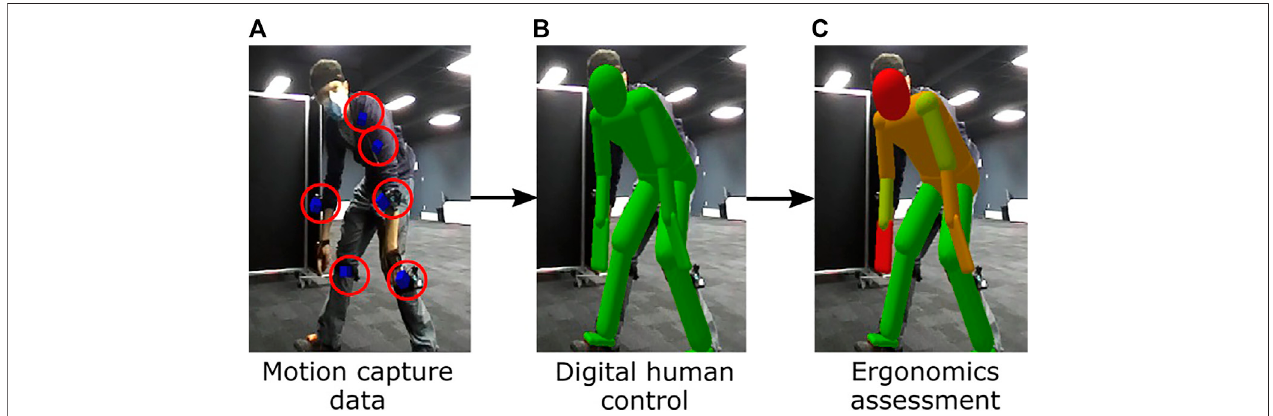
FIGURE8| Motioncapturesensors(6HTCViveTrackersforthelowertorso,uppertorso,forearmsandlegs,and5Xsenssensorsforthehands,feetandhead)are used tocapturetheuser ’ sposture (A) .Adigitalhumanmodeliscontrolledtomimictheuser ’ spositionandposture (B) .Anergonomicsassessmentisperformedbased on the digital human posture (C) . The real setup and the virtual human are rendered together thanks to a Zed camera (StereoLabs) tracked with a HTC Vive Tracker.